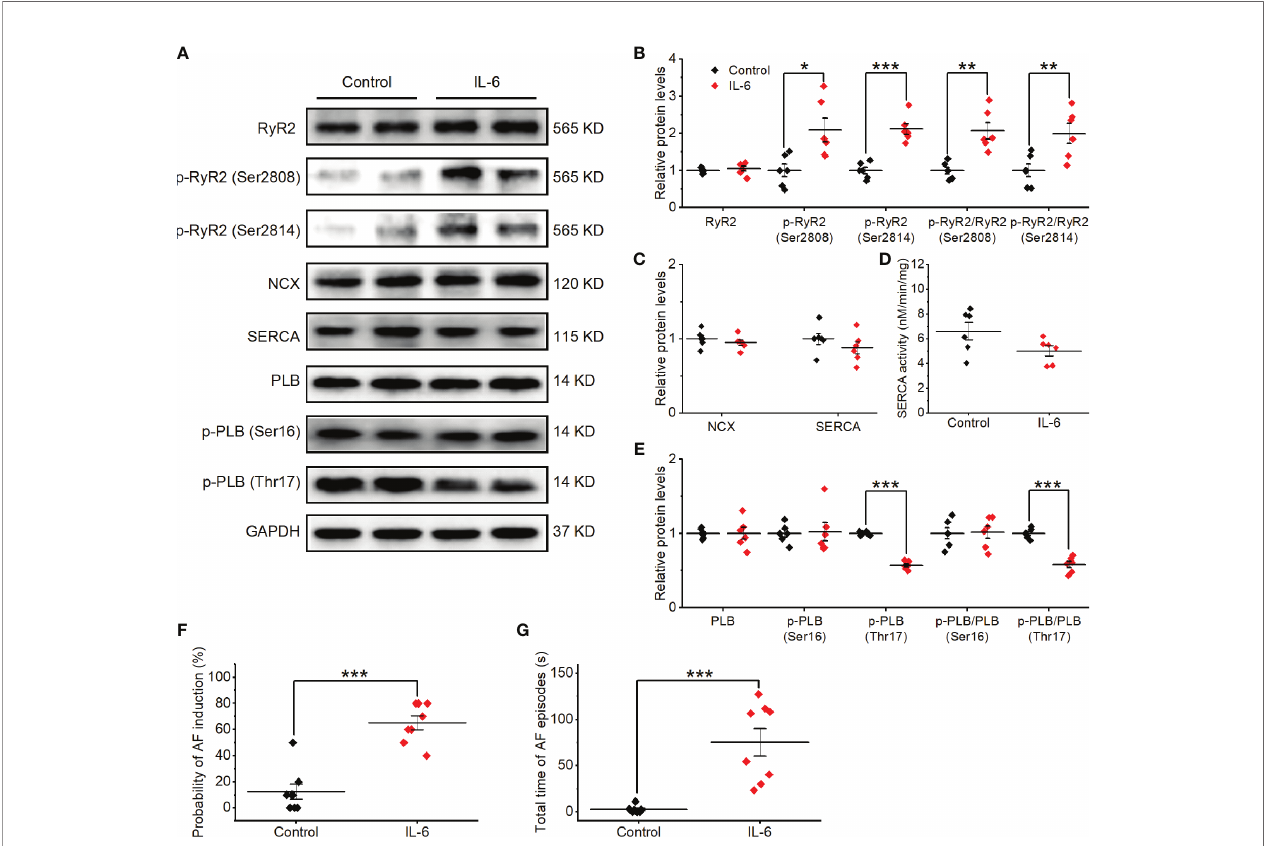
FIGURE 8 | Exogenous IL-6 administration increases the alterations in Ca 2+ handling proteins and AF induction in vivo . (A – E) Original Western blot (A) and quanti fi cation the expression of RyR2, p-RyR2 (Ser2808), p-RyR2 (Ser2814) (B) , the expression of SERCA and NCX (C) , SERCA activity (D) , the expression of PLB, p-PLB (Ser16), and p-PLB (Thr17) (E) , in atrial tissue of 2 indicated groups. n = 6/group. (F, G) Statistical results of AF duration (F) and probability (G) in the 2 indicated groups. n = 8/group. *P < 0.05, **P < 0.01, ***P < 0.001 vs . Control determined by Student